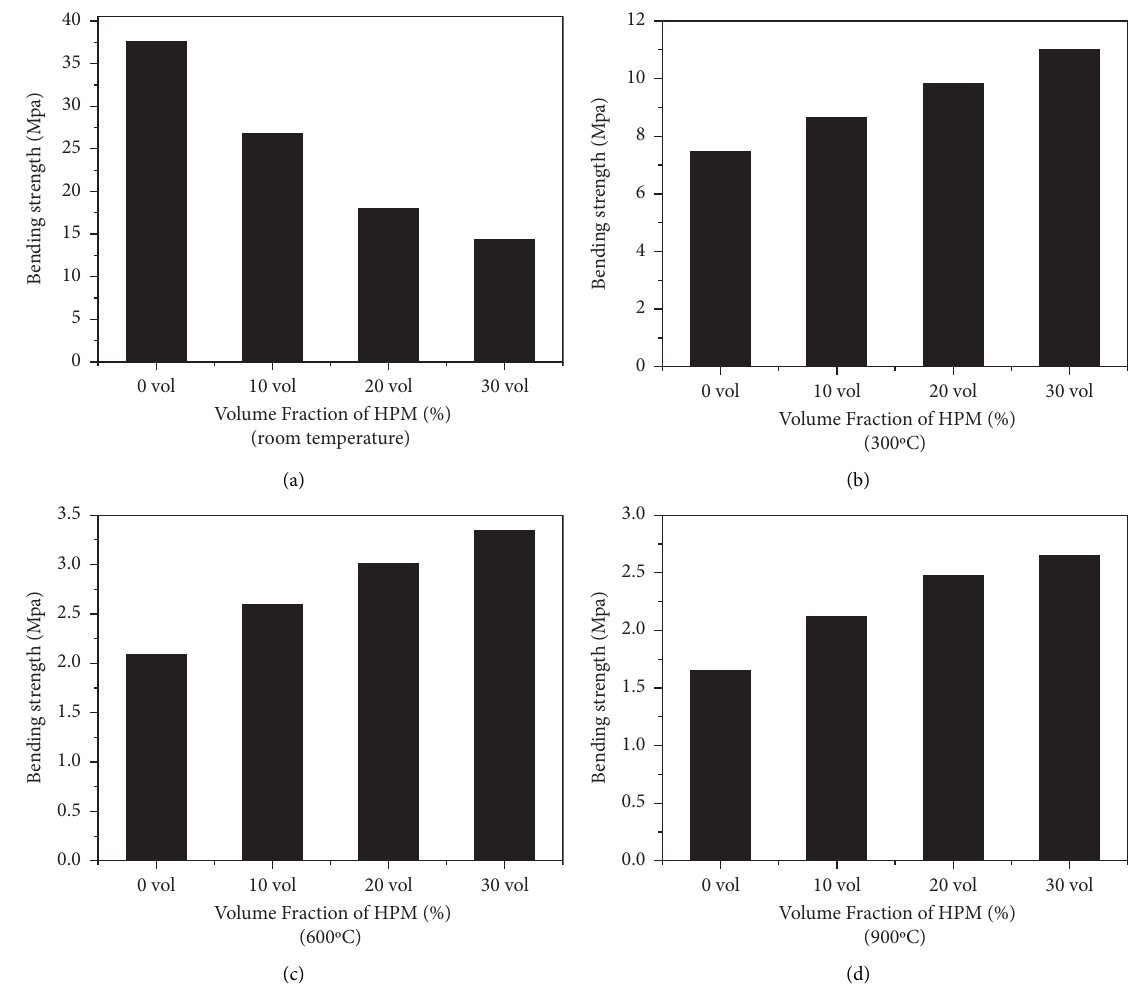
Figure 8: Flexural strength of phenolic syntactic foam at different temperatures.